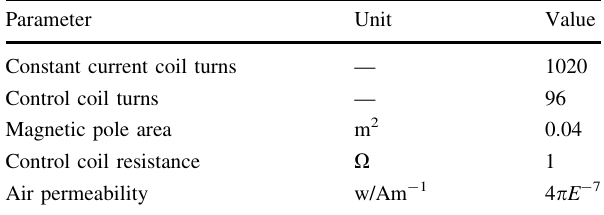
Table 1 Electromagnetic system